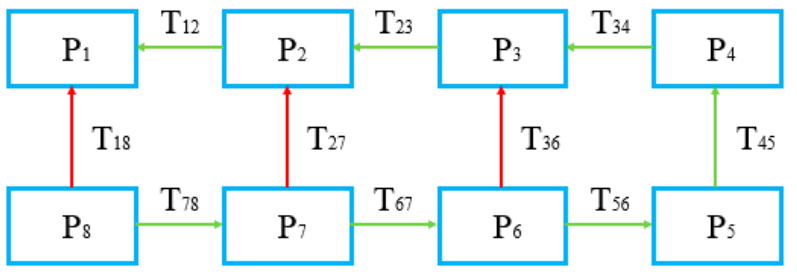
Figure 3. Illustration of graph-based optimization. The blue rectangles represent the strip data, and the arrows represent the registration relationship between them. Among these, the green arrows are the necessary observations (not unique) and the red arrows are the redundant observations.